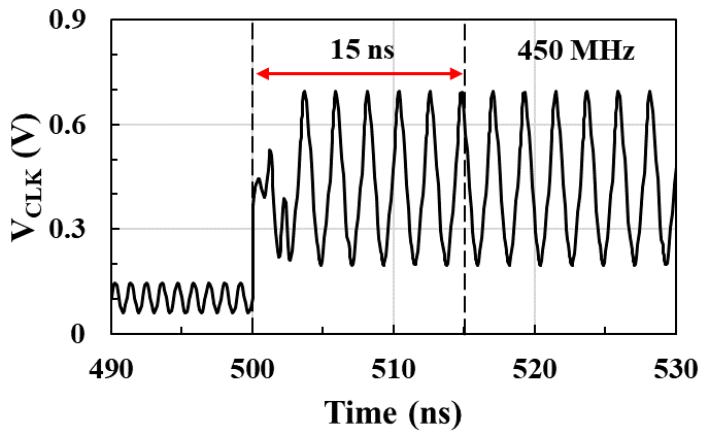
Figure 11. Output waveform of the RF injection-locked clock harvester and setup time when V DD is switched from 0 to 1 V.